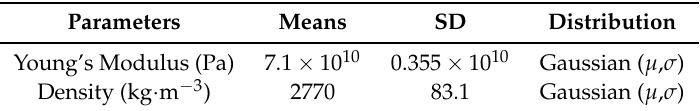
Table 4. Moments and distribution laws of the parameters of the problem.